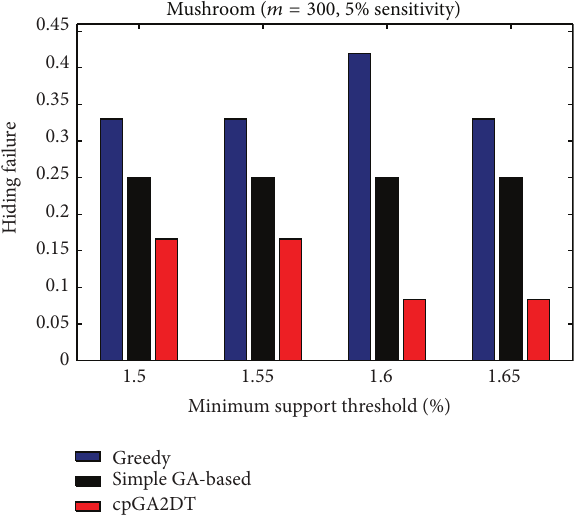
Figure 14: Comparisons of hiding failure at various sensitivity percentages of the frequent itemsets for BMSWebview-1 database.